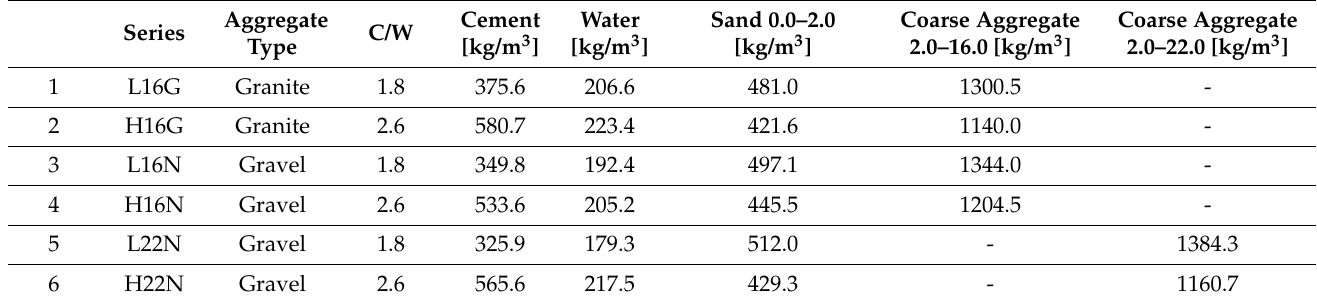
Table 1. Composition of concrete mixtures.